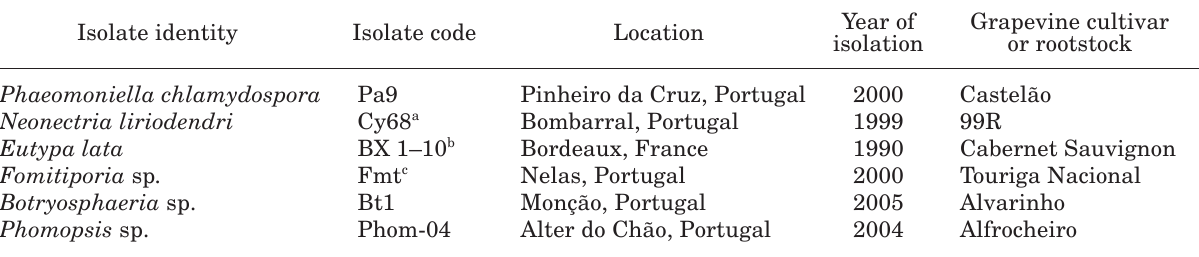
Table 1. Grapevine wood fungi isolates used in this study. Isolate identity